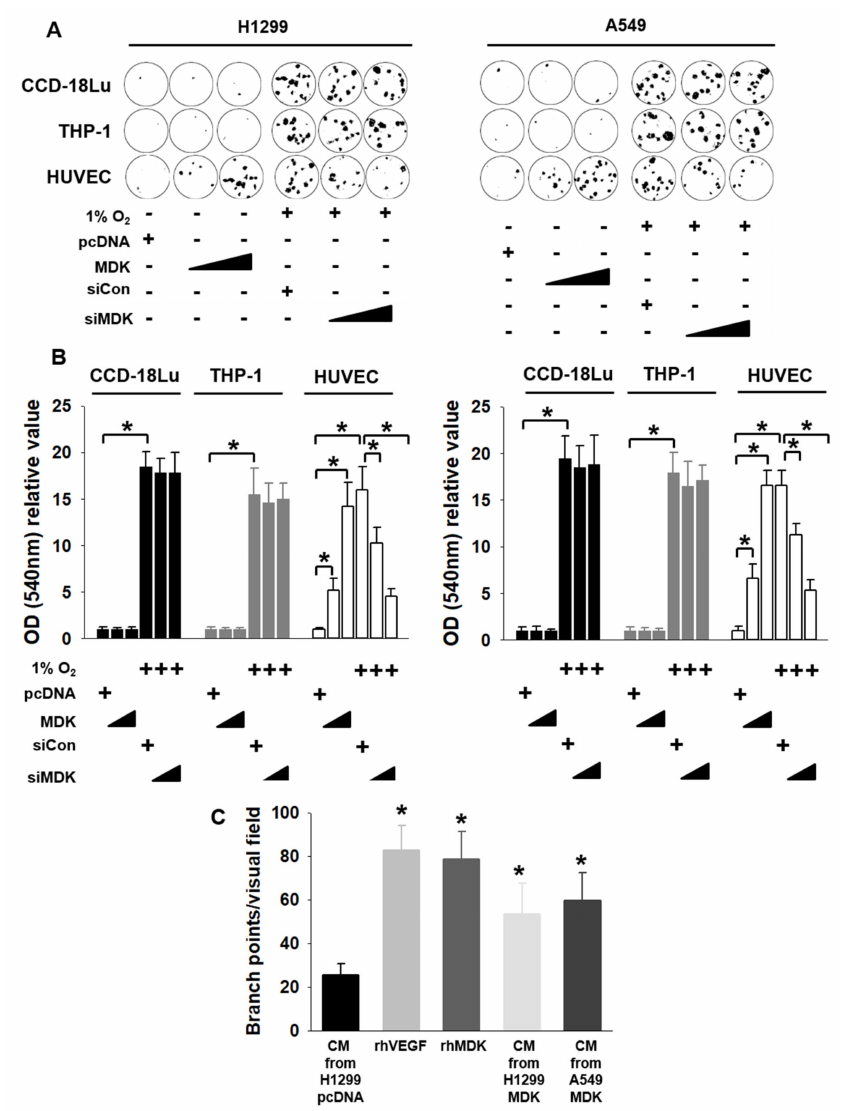
Figure 3. MDK promoted endothelial cell migration and angiogenesis in NSCLC